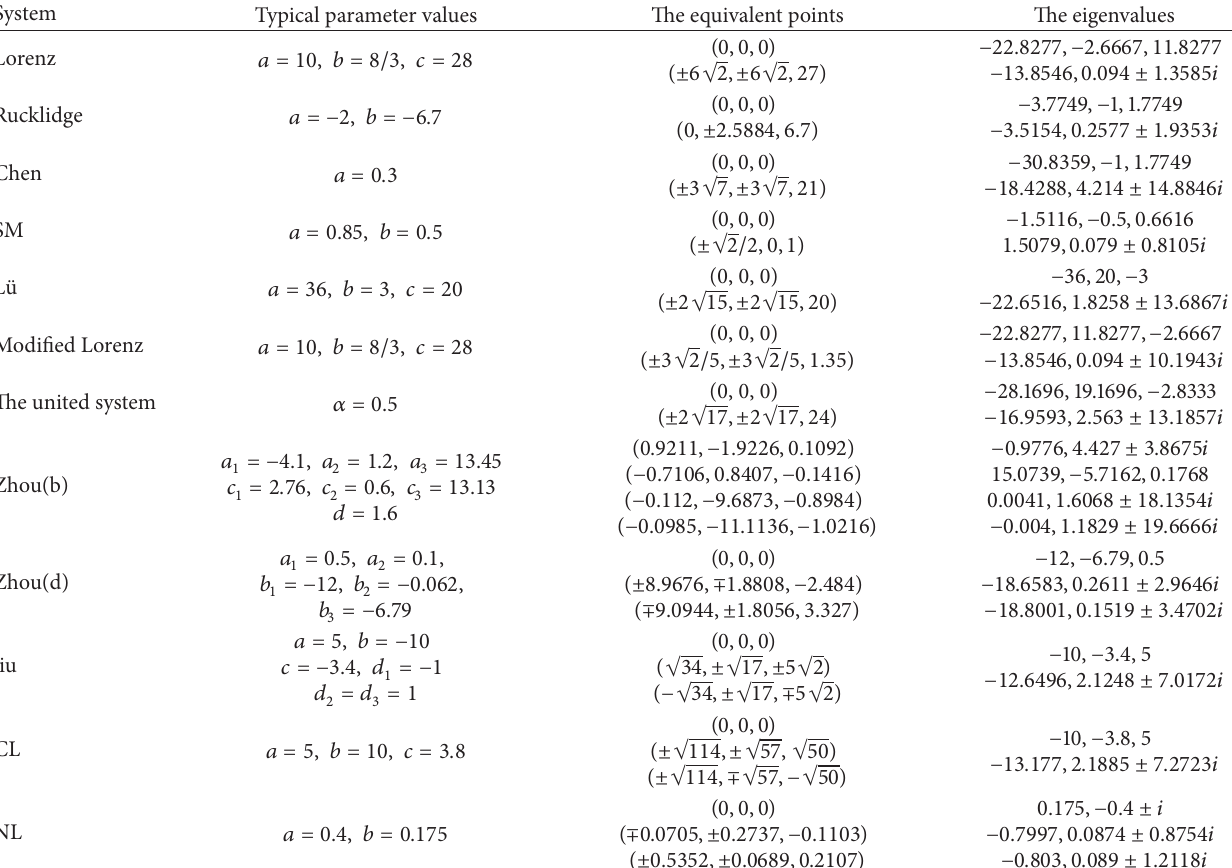
Table 3: The systems with three and more equilibrium